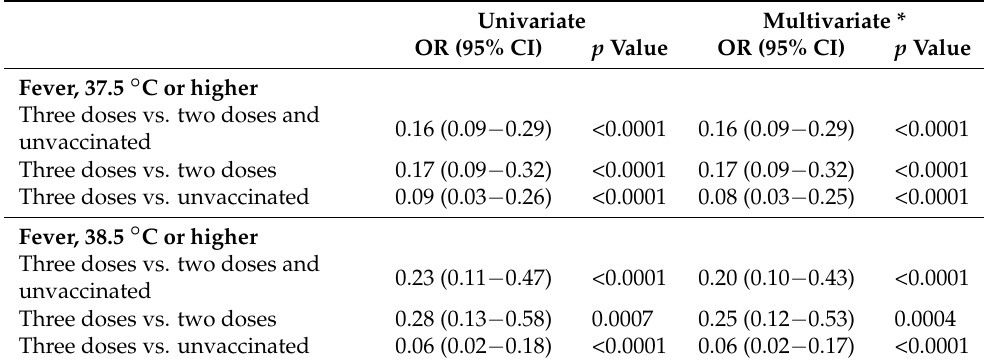
Table 2. Odds ratios of fever of ≥ 37.5 ◦ C or ≥ 38.5 ◦ C after three doses of vaccine compared with two doses and those who were unvaccinated. Univariate Multivariate * OR (95%